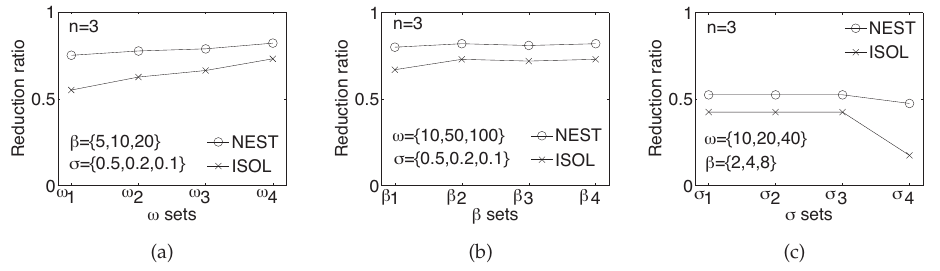
Figure 9: Reduction ratio under nested and isolated window maintenance.